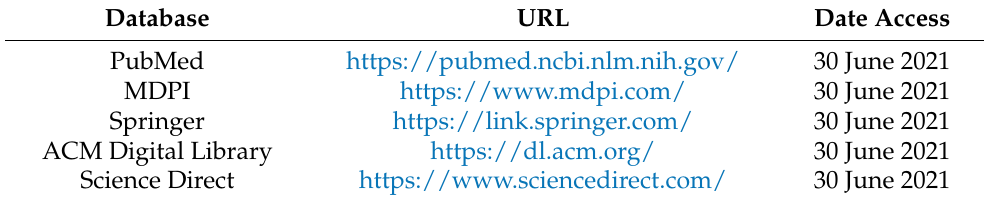
Table 1. Databases used for this